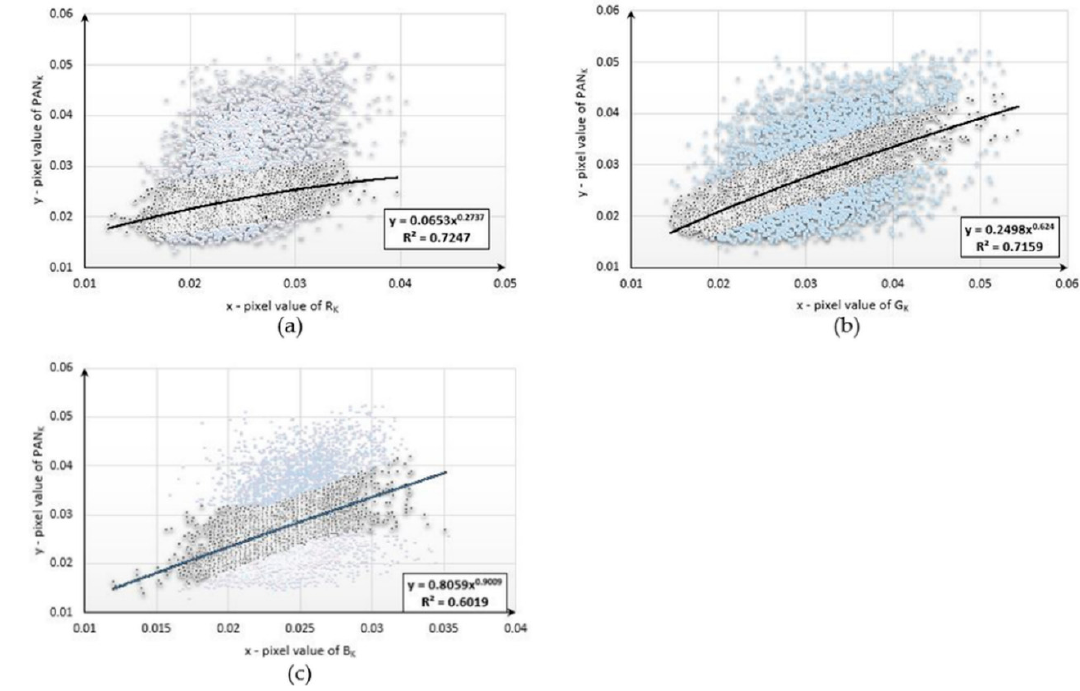
Figure 4. Diagrams presenting the functional relationships for the forest sample: ( a ) between PAN and red bands; ( b ) between PAN and green bands; ( c ) between PAN and blue bands. Sensors 2020 , 20 , x FOR PEER REVIEW